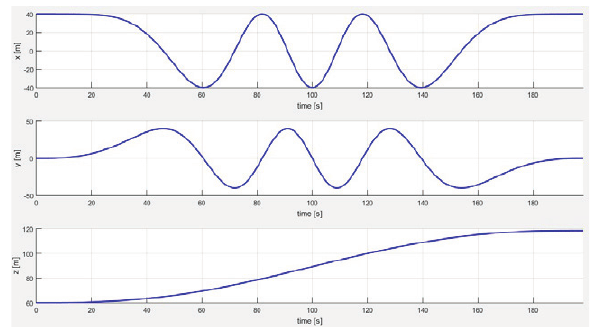
Figure 10. Position over the three axes defined by the